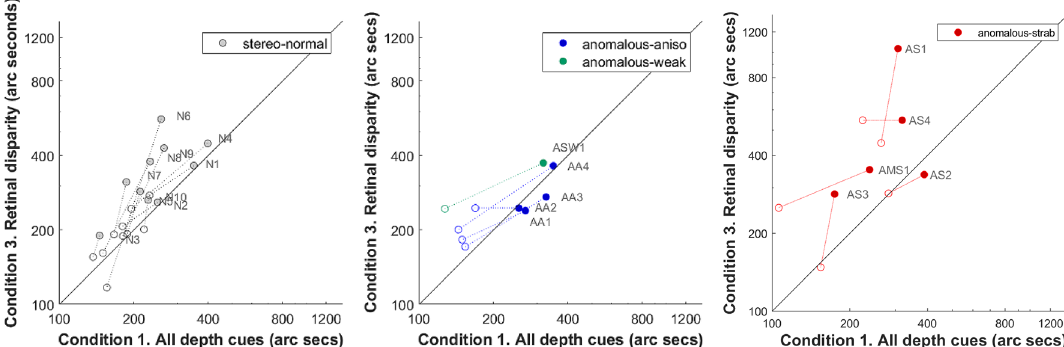
Figure 6. DartBoard in-game performance accuracy initial thresholds and PPR in two cue scaffolding Conditions (1 vs 3) for each group (stereo-normal and stereo-anomalous with strabismic participants plotted separately for less crowding). Each participant is represented as a line, whose start point is a filled circle and end point is an open circle. The start point of the line represents the initial accuracy (arc secs); horizontal line length shows the improvement in game accuracy for Condition 1, and vertical length is the improvement in game accuracy for Condition 3. Points above the diagonal unity line show better performance when all depth cues are present compared to the performance when only retinal disparity is available (as naturally occurs). Lines with angles lower than 45 degrees show greater improvement with all cues than for stereoacuity alone. Stereo- normal participants are represented in gray, stereo-anomalous are represented in different colors depending on subclassification: anisometropic in blue, strabismic in red, stereo-weak in